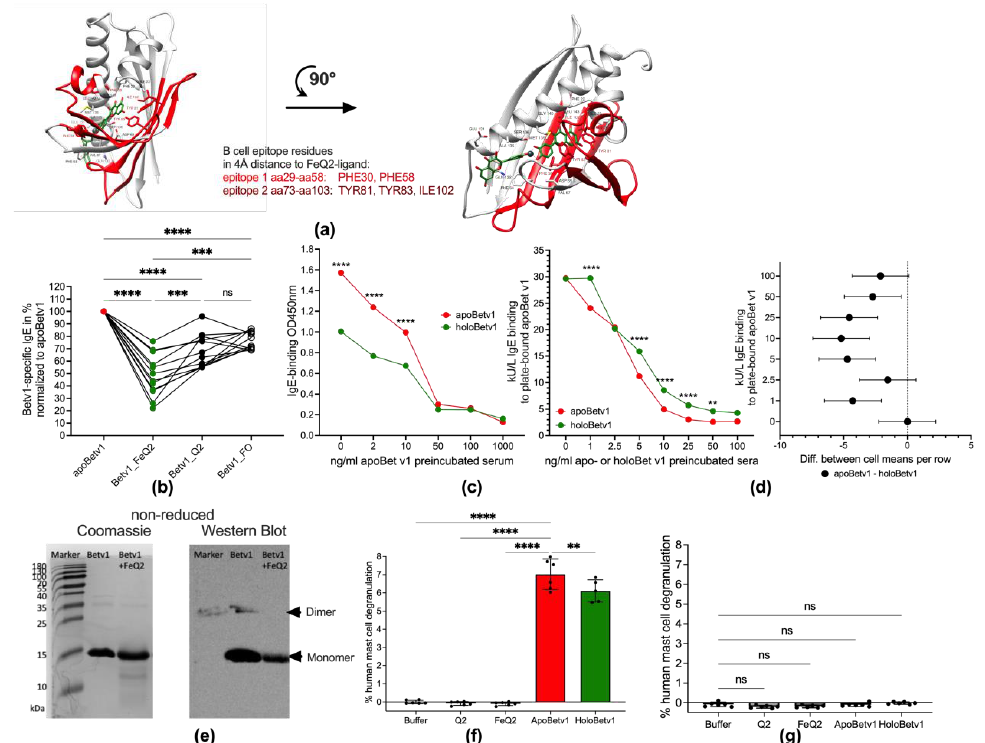
Figure 2. Binding of iron—quercetin complex by Bet v 1 masks B cell epitopes and affects IgE binding and mast cell degranulation ( a ): Structure of Bet v 1—Fe(quercetin) 2 complex shown as cartoon from two different views. Iron complexed by two quercetins (FeQ2) is depicted as sticks with carbons in green and oxygens in red. Iron atom (Fe) is represented as a grey sphere. Major B-cell epitope 1 (29–58) and epitope 2 (73–103) are marked in light and dark red, respectively. Residues within a 4Å distance from any atom of FeQ2 are shown as sticks with carbons in red. ( b ): Serum IgE binding of birch pollen allergic ( n = 12) to Bet v 1 without cargo (apoBet v 1) or in combination with iron-quercetin (Bet v 1_FeQ2), quercetin (Bet v 1_Q2), or ferroxamine (Bet v 1_FO). ( c ): Blocking experiments with pooled birch pollen allergic incubated with increasing doses of apo Bet v 1 and binding to plate-bound apo- (red line) or holoBet v 1 (green line). ( d ): Summary and confidence interval plot of blocking experiments incubating 6 individual sera of birch pollen allergic subjects with increasing doses of apo- or holoBet v 1 and assessing IgE binding to plate-bound apoBet v 1. ( e ): Protein bands stained by Coomassie and serum IgE binding against Bet v 1 alone or in combination with FeQ2 of gels run under non-reducing conditions. Degranulation of human mast cells sensitized with pooled ( f ) birch pollen allergic ( g ): non-allergic sera. For statistical analyses ( b ) was compared with RM one-way ANOVA with Geissner Greenhouse correction and Holm-Sid á k’s multiple comparisons test ( c , d ) with two-way ANOVA using Holm-Sid á k’s multiple comparisons test, with a single pooled variance, ( f ) with mixed-effect analyses using the Geissner Greenhouse correction and Holm-Sid á k’s multiple comparisons test, ( g ) with one-way ANOVA following Holm-Sid á k’s multiple comparisons tes. Mean ± SD; ns not significant, ** p < 0.01, *** p < 0.001, **** p <